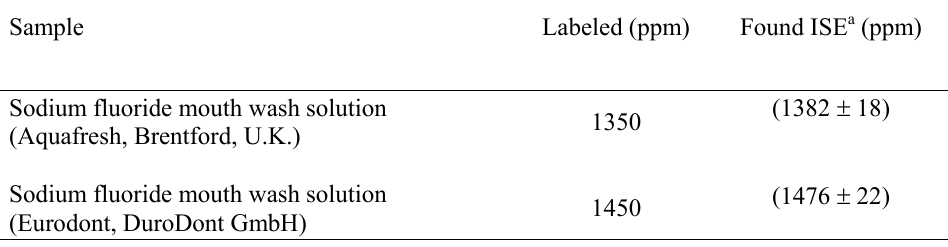
Table 5. Fluoride ions determination in mouth wash